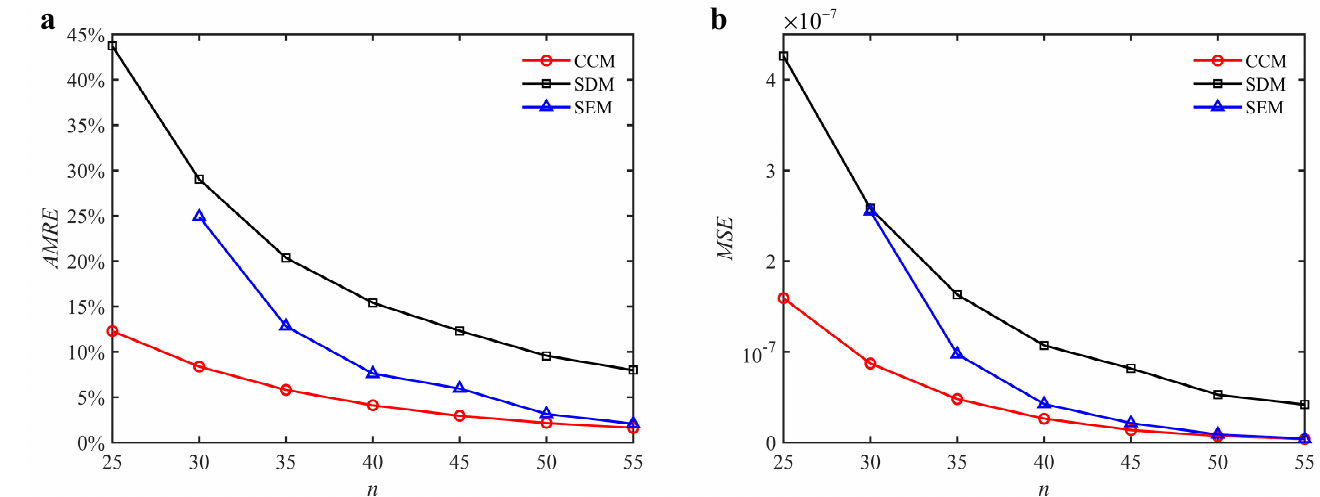
Figure 3. AMRE and MSE of the CCM, SDM, and SEM when a / D = 1. ( a ) AMRE ; ( b ) MSE.